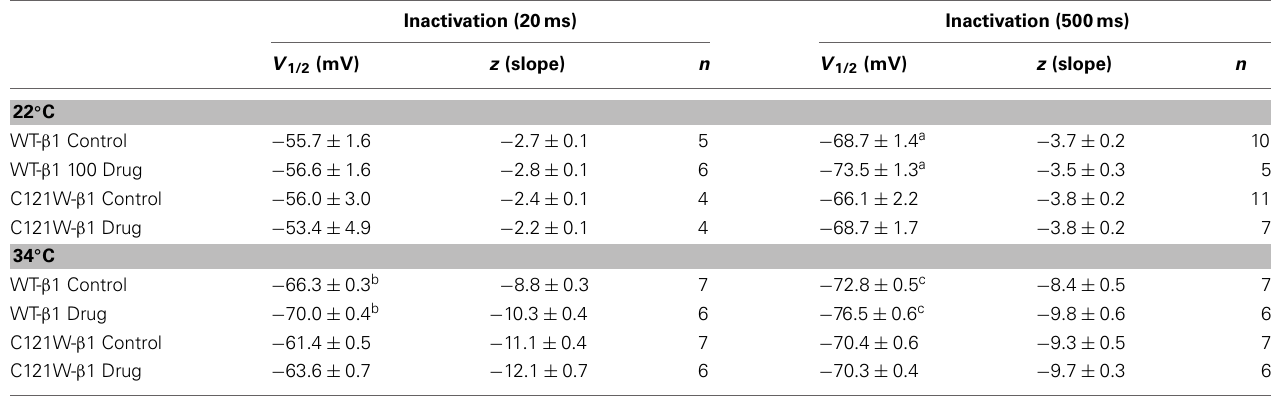
Table 3 | Steady-state fast inactivation parameters.